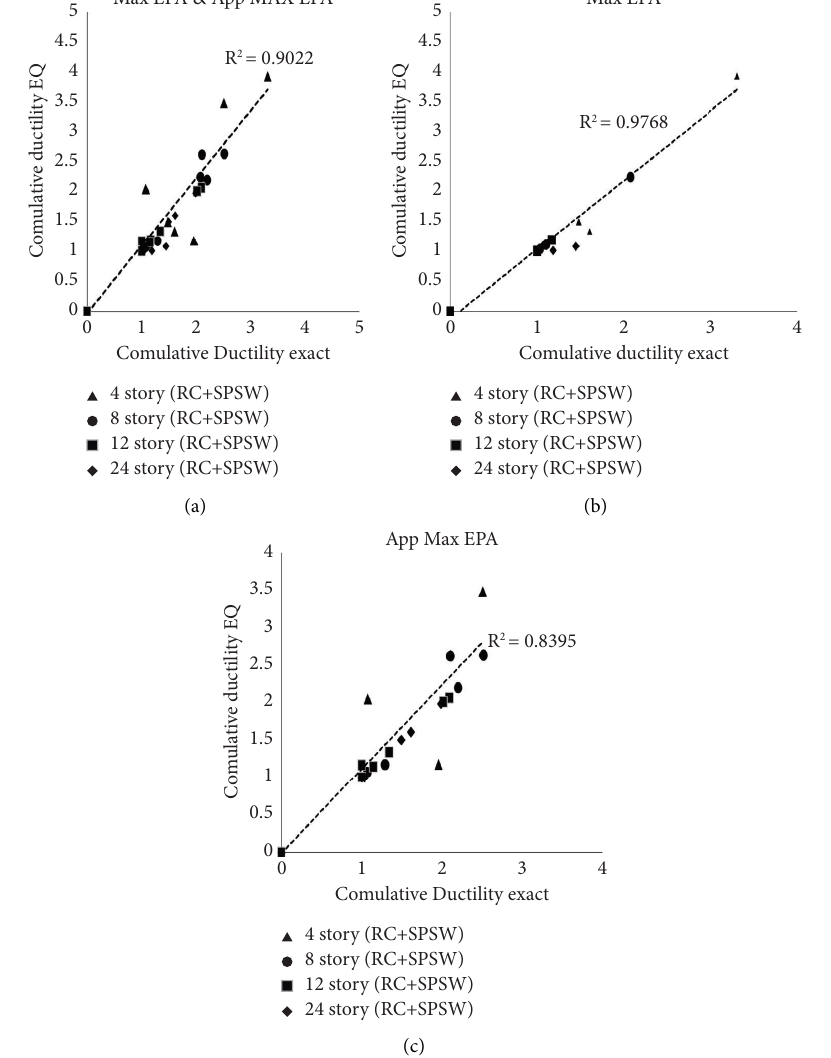
Figure 14: Comparison of cumulative ductility demand of models RCF with SPSW under SS. (a) Group I and II, (b) group I, (c) group II. Table 25: Results of peak interstory drift demand of models in the MS and SS group III. Imperial Valley Coalinga Chalfant Valley Earthquake model